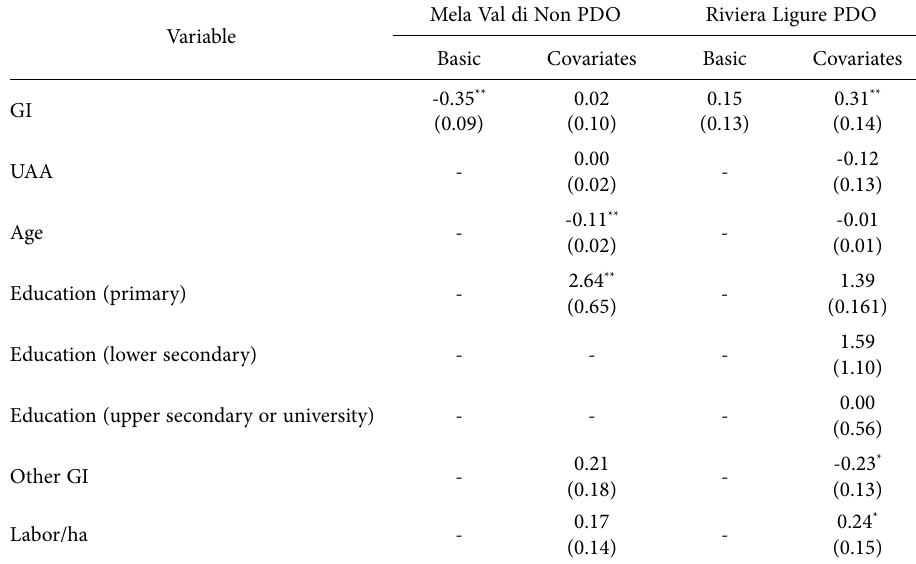
Table 3. TWFE results for Mela Val di Non PDO and Riviera Ligure PDO.